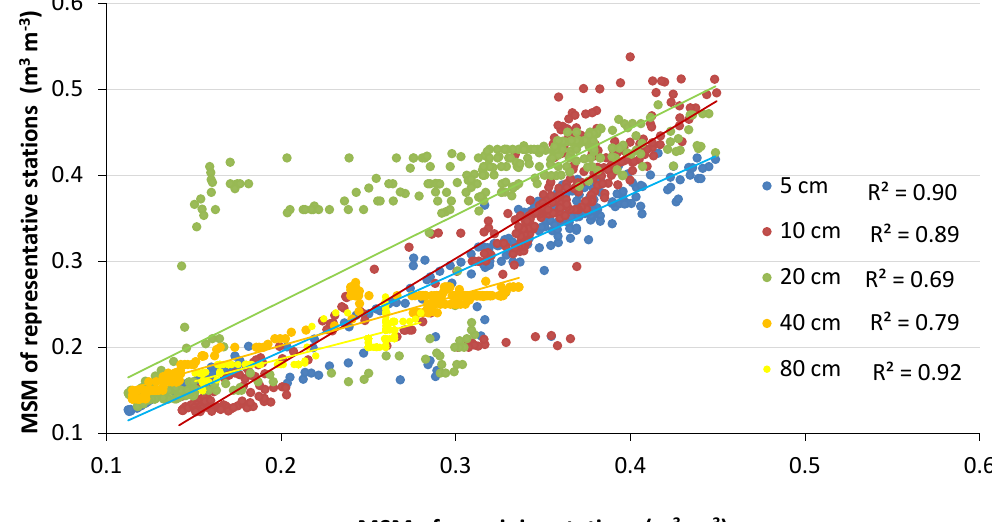
Figure 3. Coefficients of determination (R 2 ) between daily averaged observations at the respective RMSM stations and daily averaged MSM of the remaining network